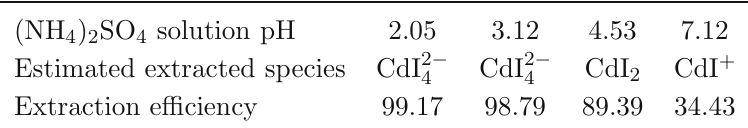
Table 1 Predicted Cd(II) species extracted with iodide in two-phase aqueous PEG(1550) – (NH 4 ) 2 SO 4